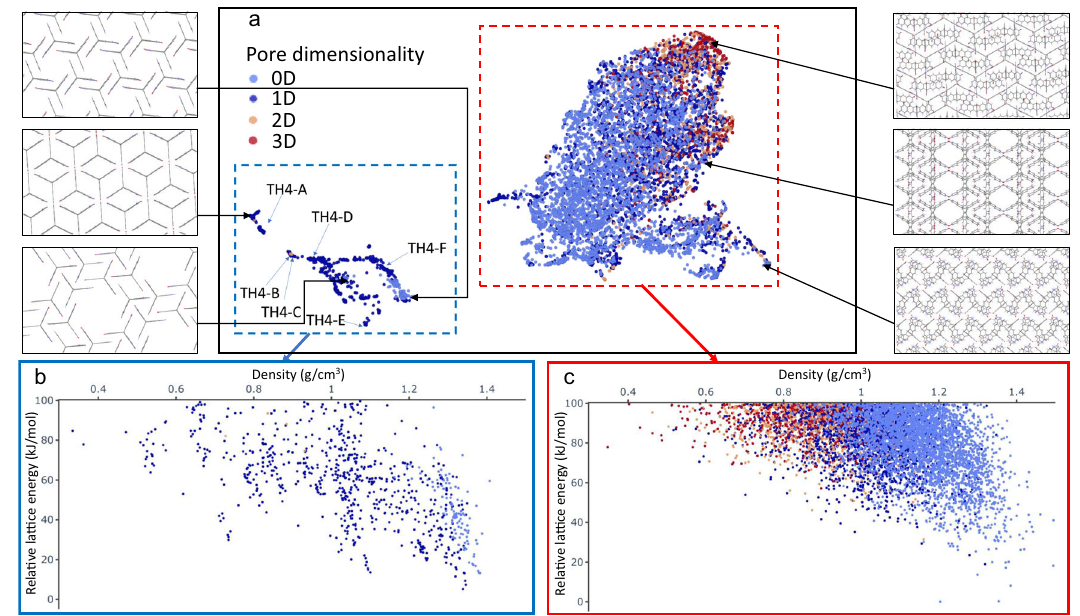
Fig. 6 The ESF data of TH4 mapped onto its SOAP space. a 2D UMAP embedding of the SOAP space of TH4 , colour coded by the pore dimensionality. b , c Energy – density landscapes correspond to the regions marked out in ( a ), colour coded by the pore